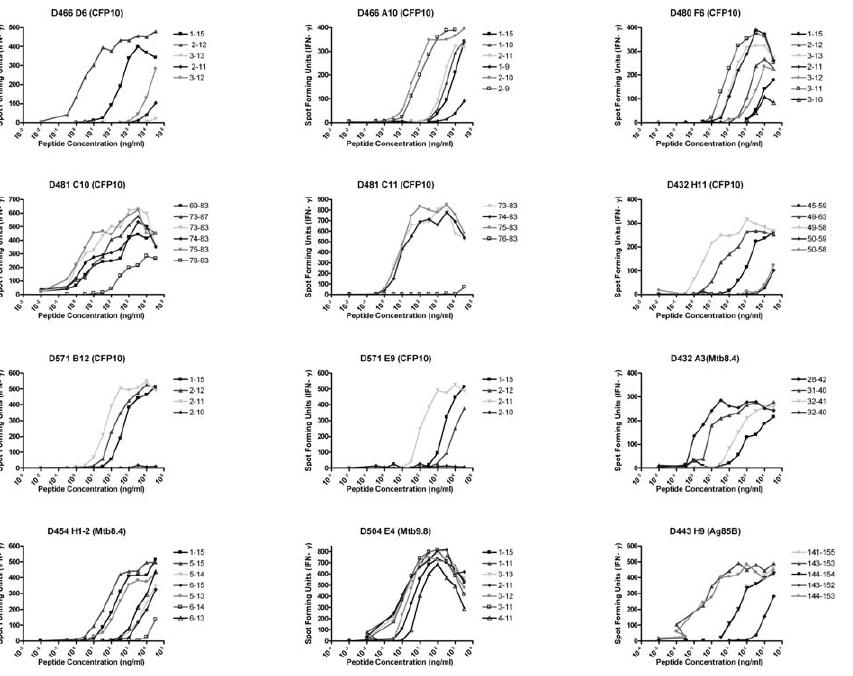
Figure 5. Summary of Minimal Epitope Mapping Data To determine the minimal epitope, autologous LCLs (20,000/well) were pulsed with peptide at the concentration indicated and co-cultured with T cells (1,000 cells/well). IFN- c was assessed by ELISPOT after 18 h co-culture. Each point represents the mean of duplicate determinations.